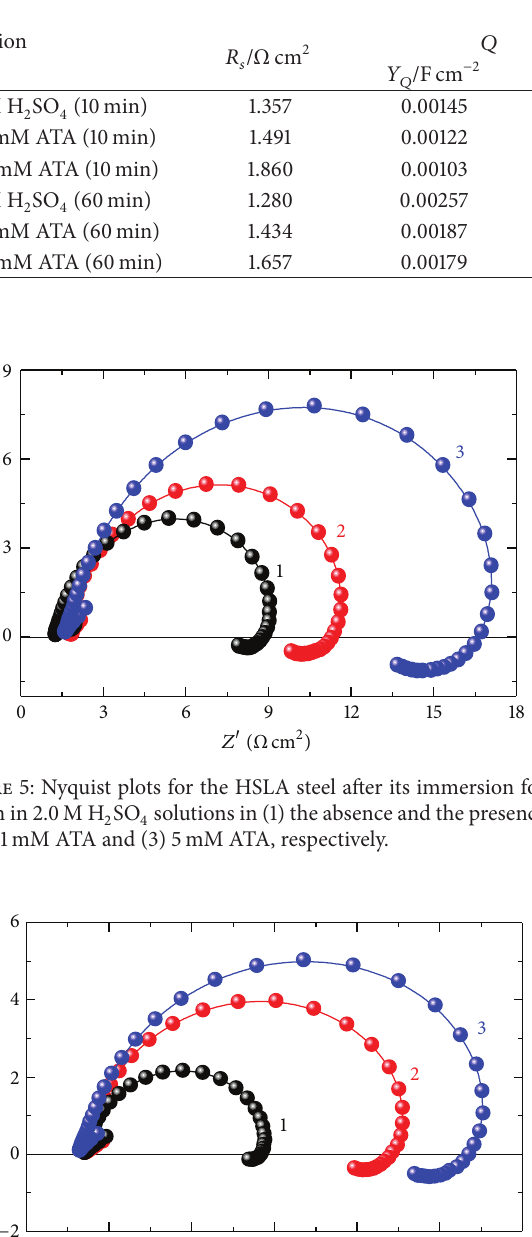
Table 1: Parameters obtained by fitting the EIS data with the equivalent circuit shown in Figure 4 for the HSLA steel in 2.0 M H Solution